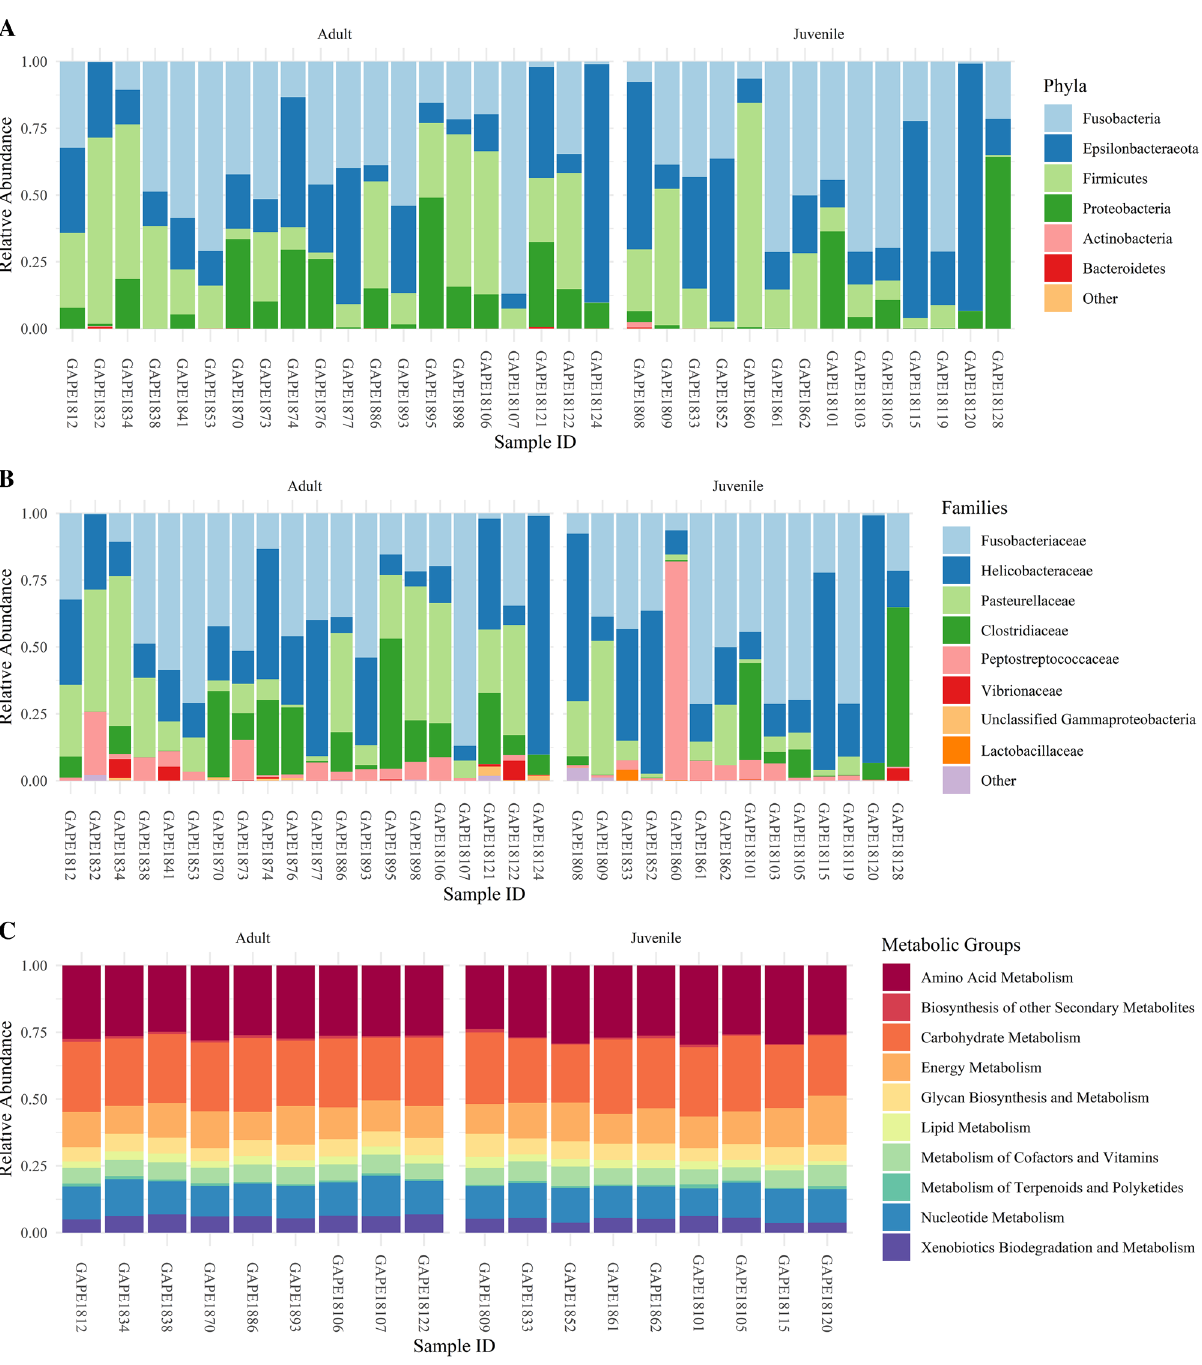
Figure 1. Bacterial phyla and families detected in 16S rRNA sequencing data ( A , B ), and metabolic KEGG pathway groups computed from shotgun sequencing data ( C ). Figure created in R using tidyverse (v. 1.3.1) 96 and cowplot (v. 1.1.1) 97